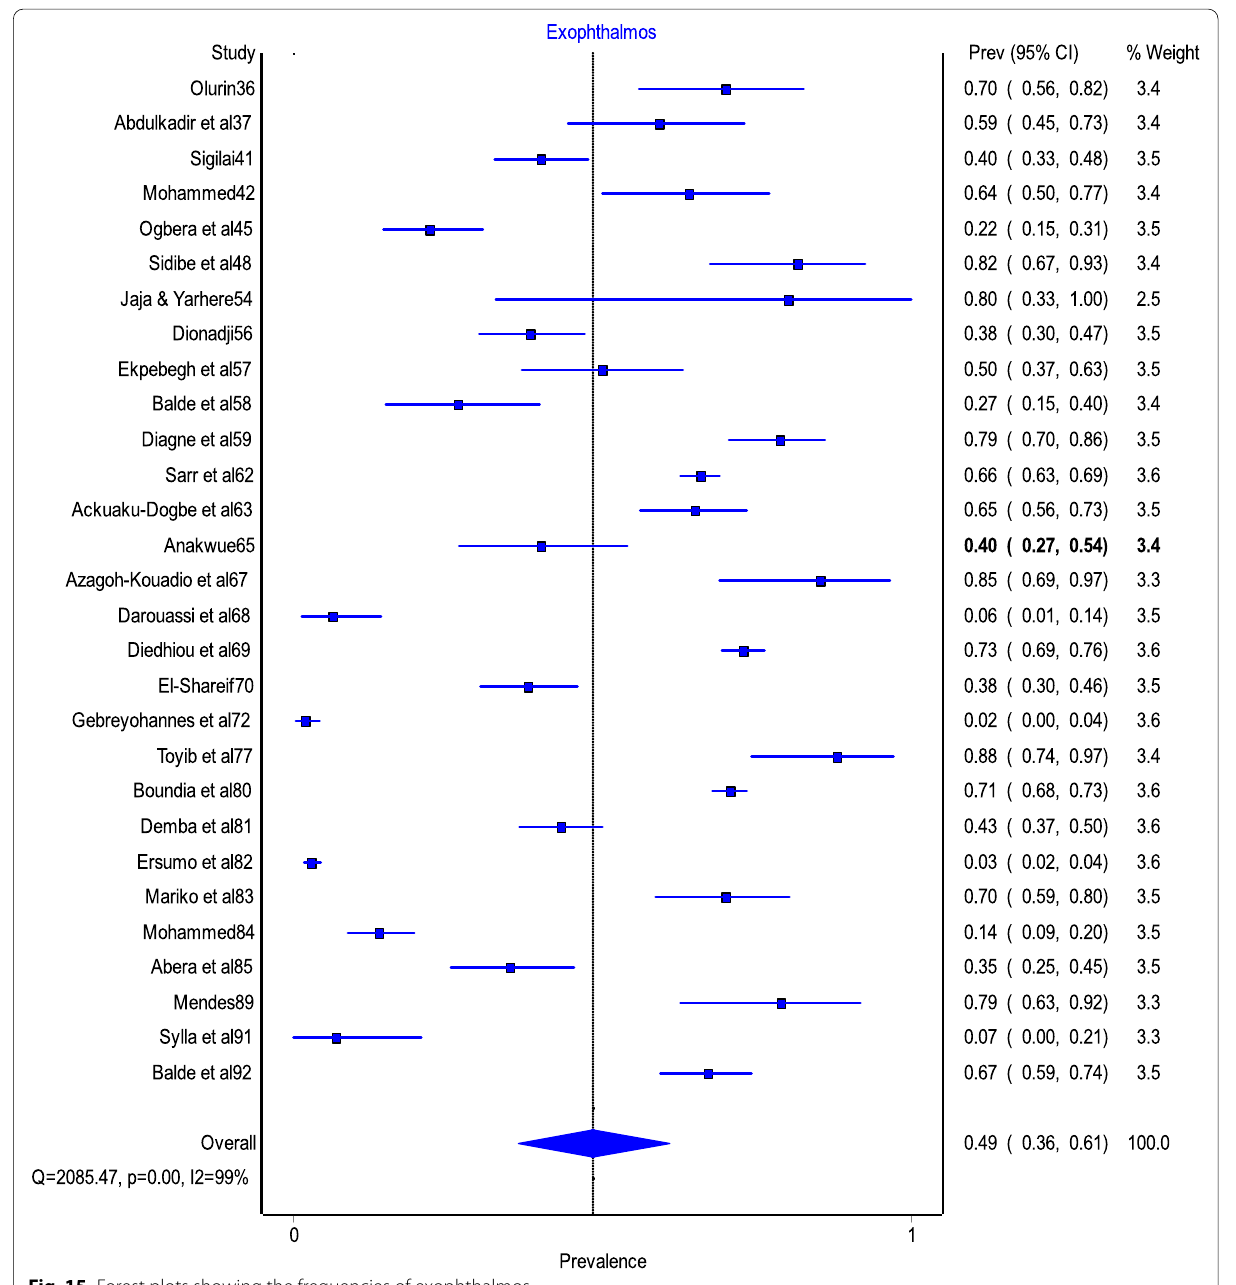
Fig. 15 Forest plots showing the frequencies of